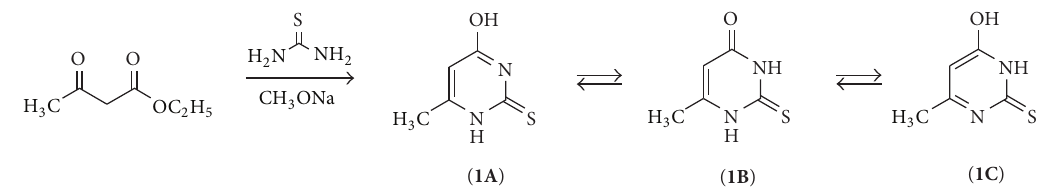
Scheme 1: Synthesis of 6-methyl-2-thioxo-2,3-dihydropyrimidin-4(1H)-one.